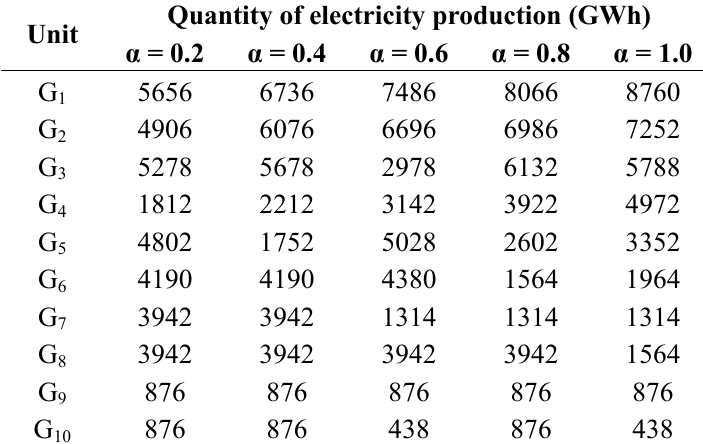
Table 6. Electricity generated by each unit under different permitted emission